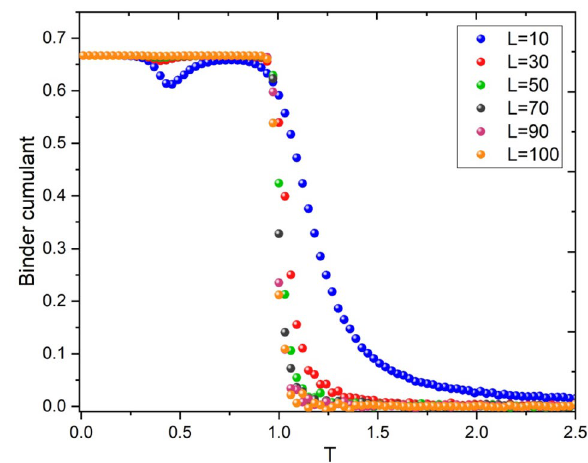
Fig. 6 The total magnetization of the system versus temperature for different crystal field values at fixed J 1 = 1.8, J 2 = 0.3, J 12 = − 0.1.